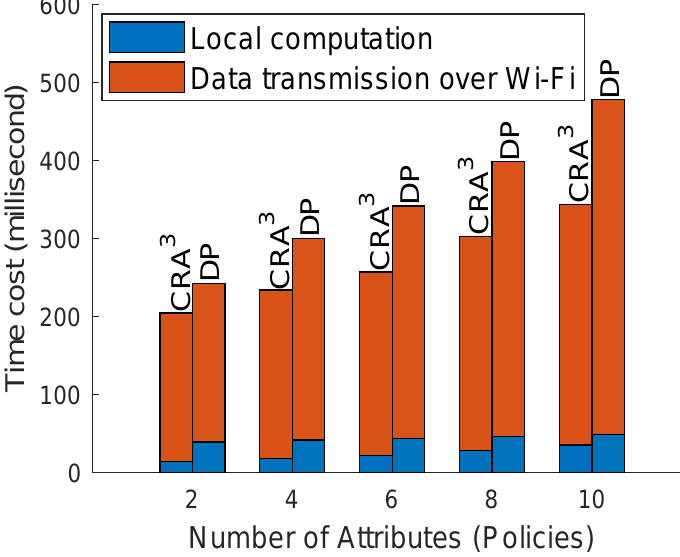
Figure 5. Comparison of total time cost of CRA 3 and DP [12].